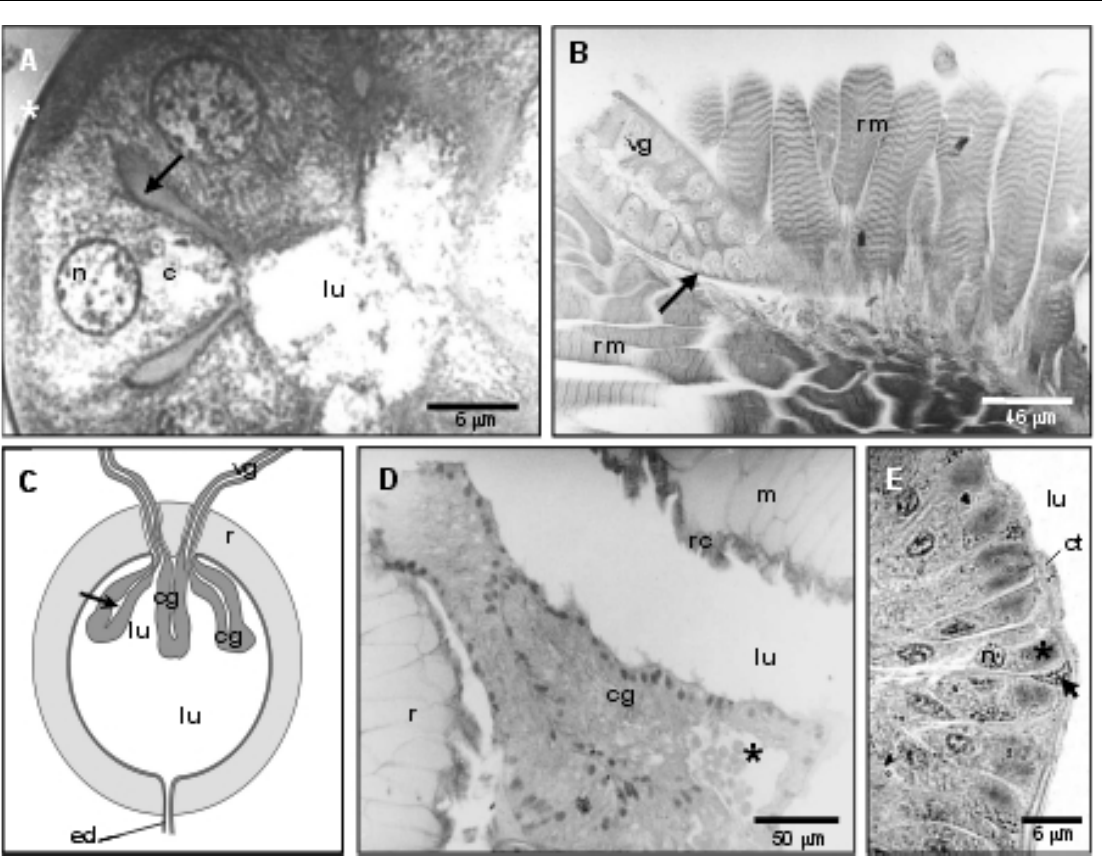
Figure 2 – (A) Venom gland in transversal section view showing its secretory cells (note the prominent intercellular space indicated by the arrow and the extracellular matrix covering the gland indicated by the asterisk); (B) Venom gland penetrating the reservoir wall; (C) Schematic view of the venom glands, convoluted glands, and the reservoir (the arrow indicates the space inside the convoluted gland that is continuous with the hemolymph); (D) Convoluted gland epithelium (the asterisk shows the same region indicated in the previous figure by the arrow); (E) Detail of the convoluted gland showing two epithelial cell types. The first type (arrow) is small and presents a flattened cytoplasm, while the second type occurs in larger numbers resembling columnar cells (the asterisk indicates the accumulation of secretion in the apical area). c - cytoplasm; cg – convoluted gland; ct - cuticle; ed - excretory duct; lu - lumen; n – nucleus; r - reservoir; rm - reservoir musculature; st - sting; vg - venom